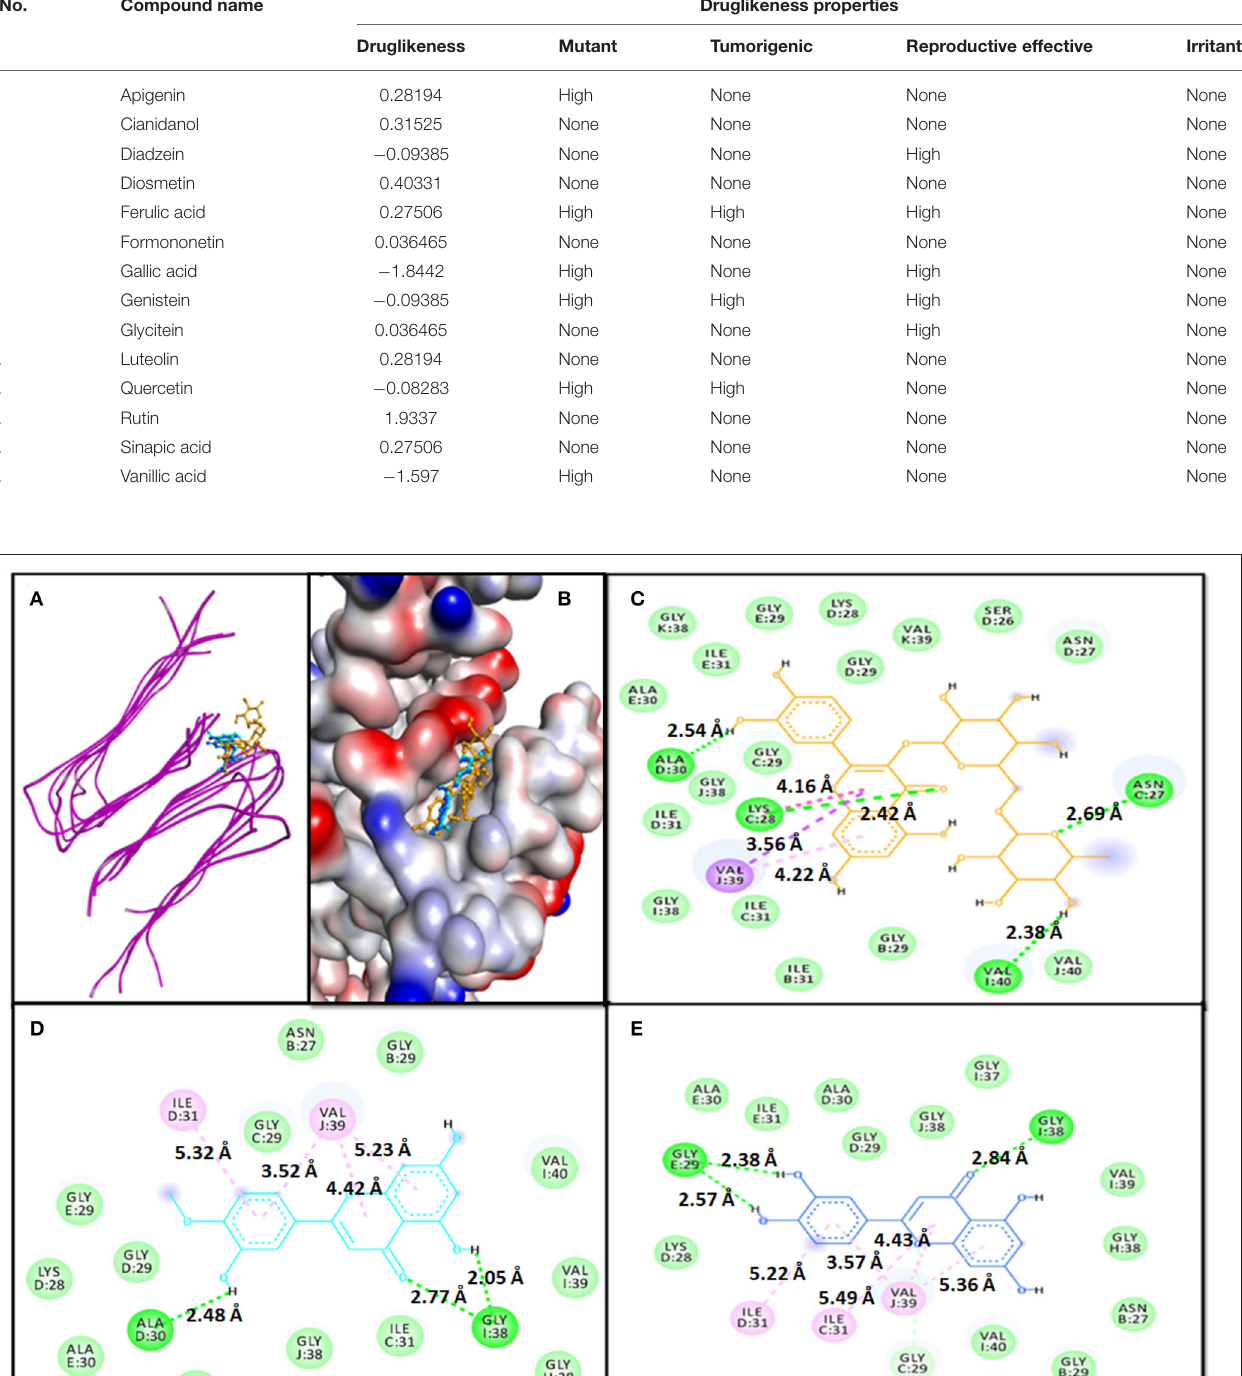
Frontiers in Neuroscience |